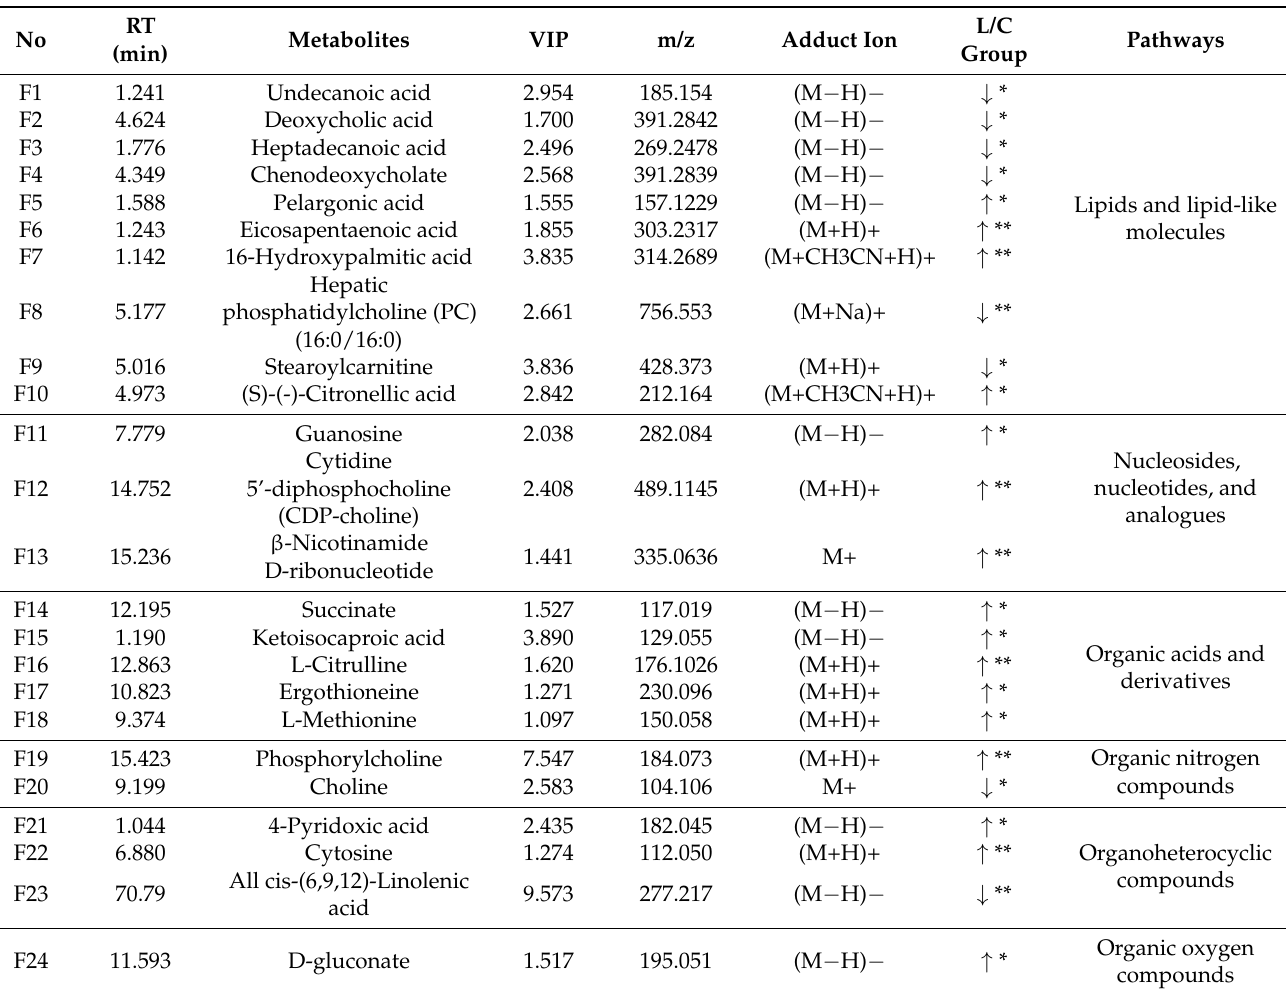
Table 1. The different tail fat metabolic profiles between the LTF and